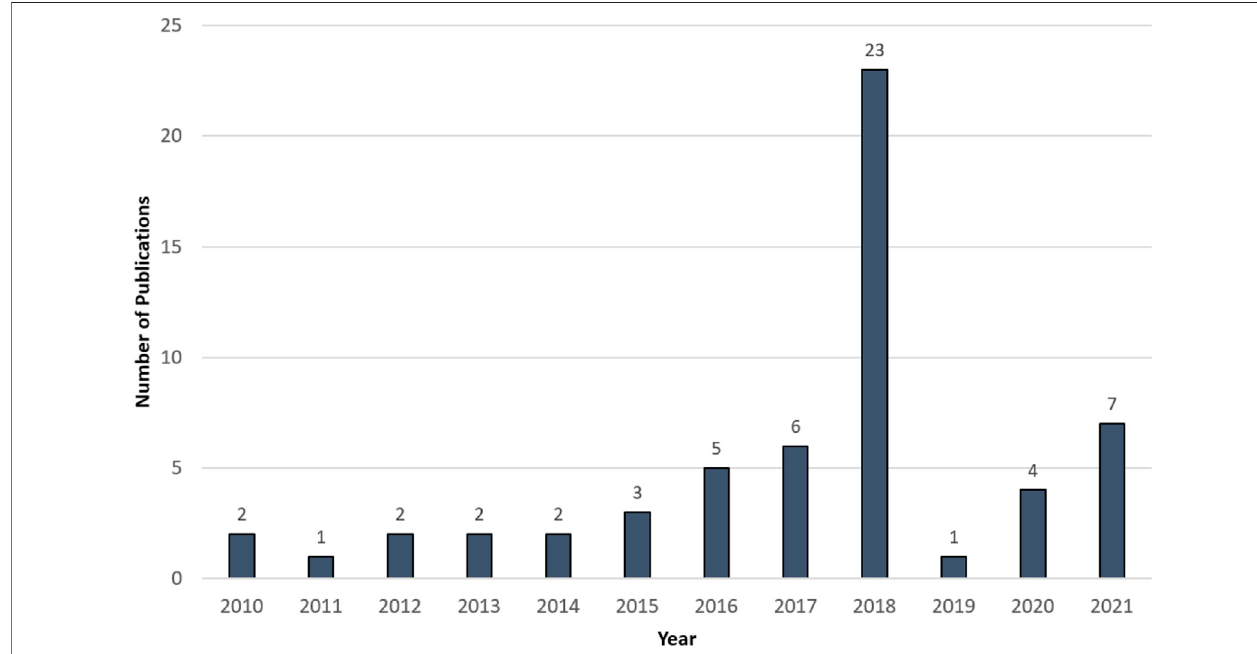
FIGURE4| Anorderedgroupedlistofpublicationsaccordingtotheirpublicationyear.TheseresultswerecollectedbysearchingScopus 4 forthekeywords Graph Rewriting and Building Information Modeling